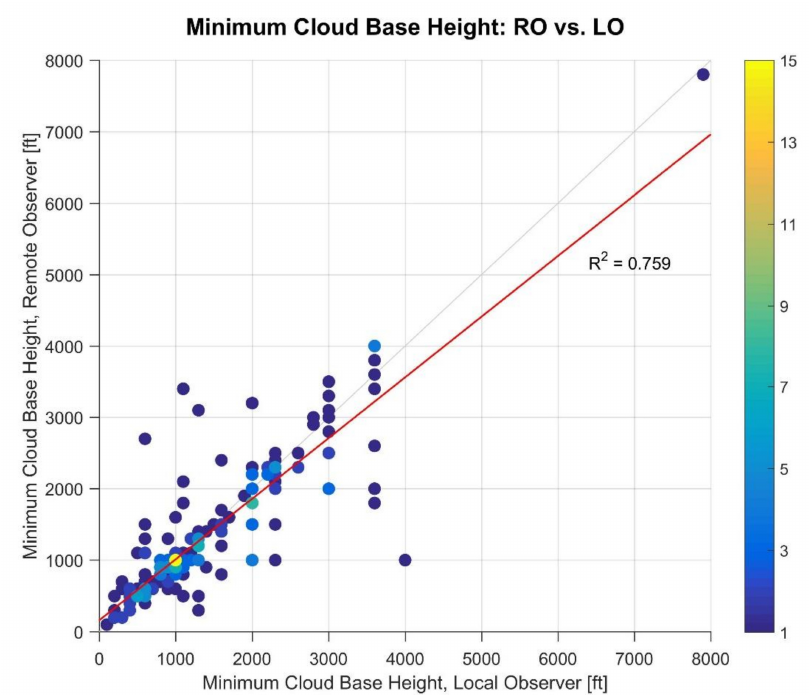
Figure 8. The same as Figure 7, but with the lowest cloud base determined by the local observers (LO) and the remote observers